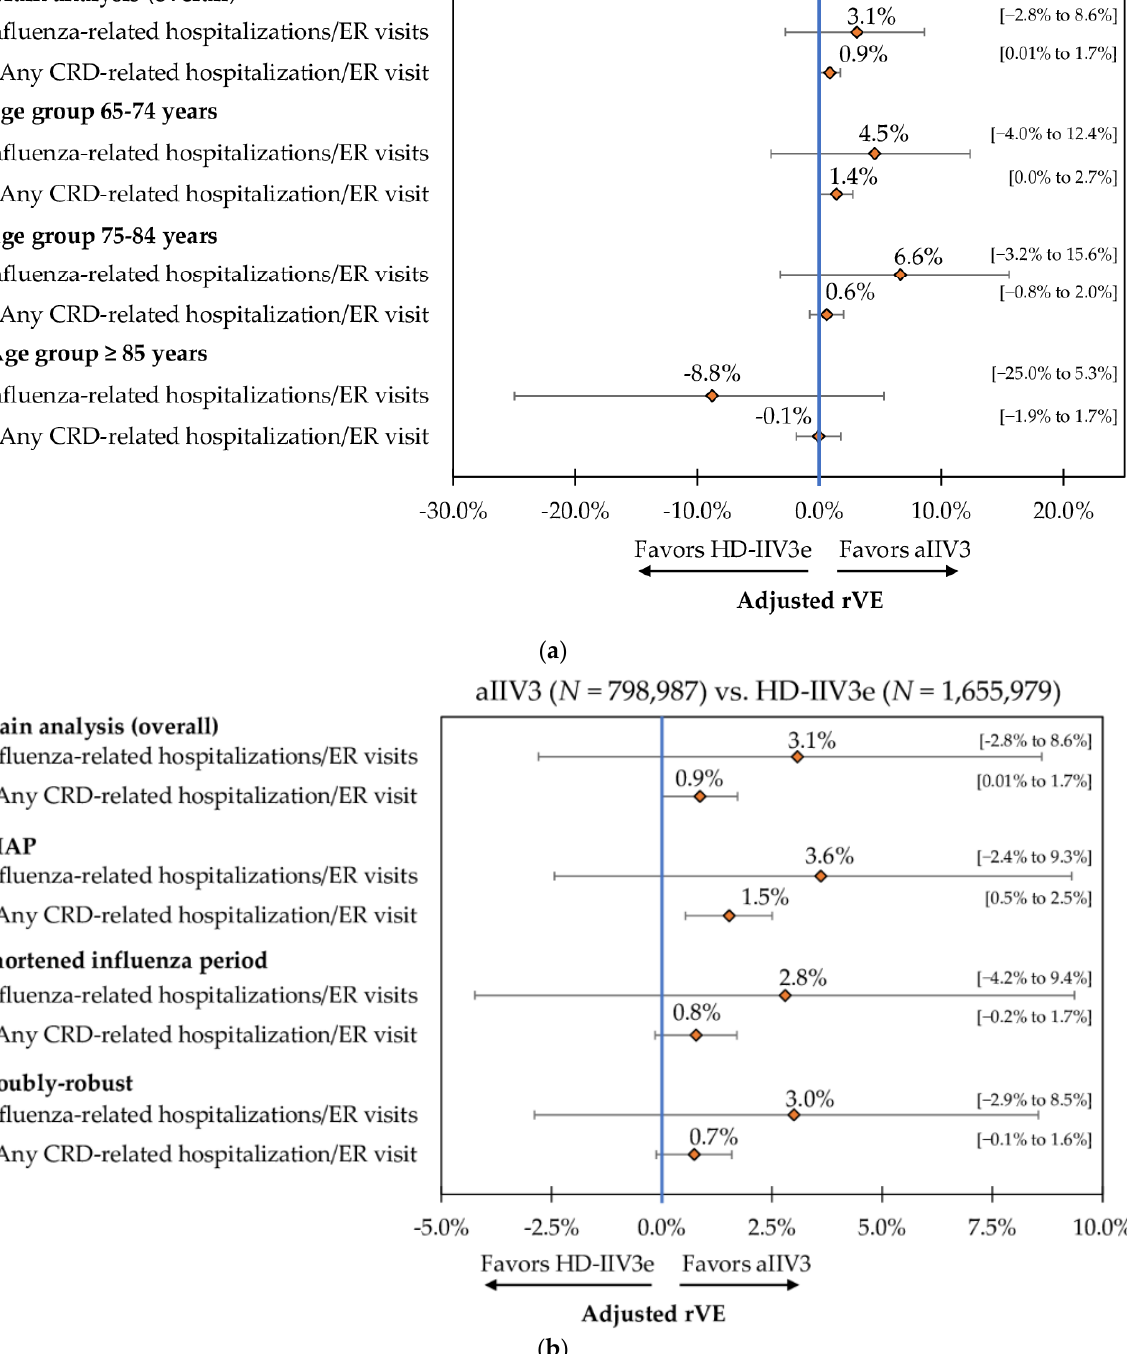
Figure 4. ( a ) Adjusted rVE (95% CI)—Post-IPTW and Poisson Regression—aIIV3 vs. HD-IIV3e from Age Sub-group Analysis. ( b ) Adjusted rVE (95% CI)—Post-IPTW and Poisson Regression—aIIV3 vs. HD-IIV3e from Sensitivity Analysis. aIIV3 = adjuvanted trivalent influenza vaccine; CRD = cardio-respiratory disease; ER = emergency room; HD-IIV3e = high-dose trivalent influenza vaccine; rVE = relative vaccine effectiveness; UTI = urinary tract infection.